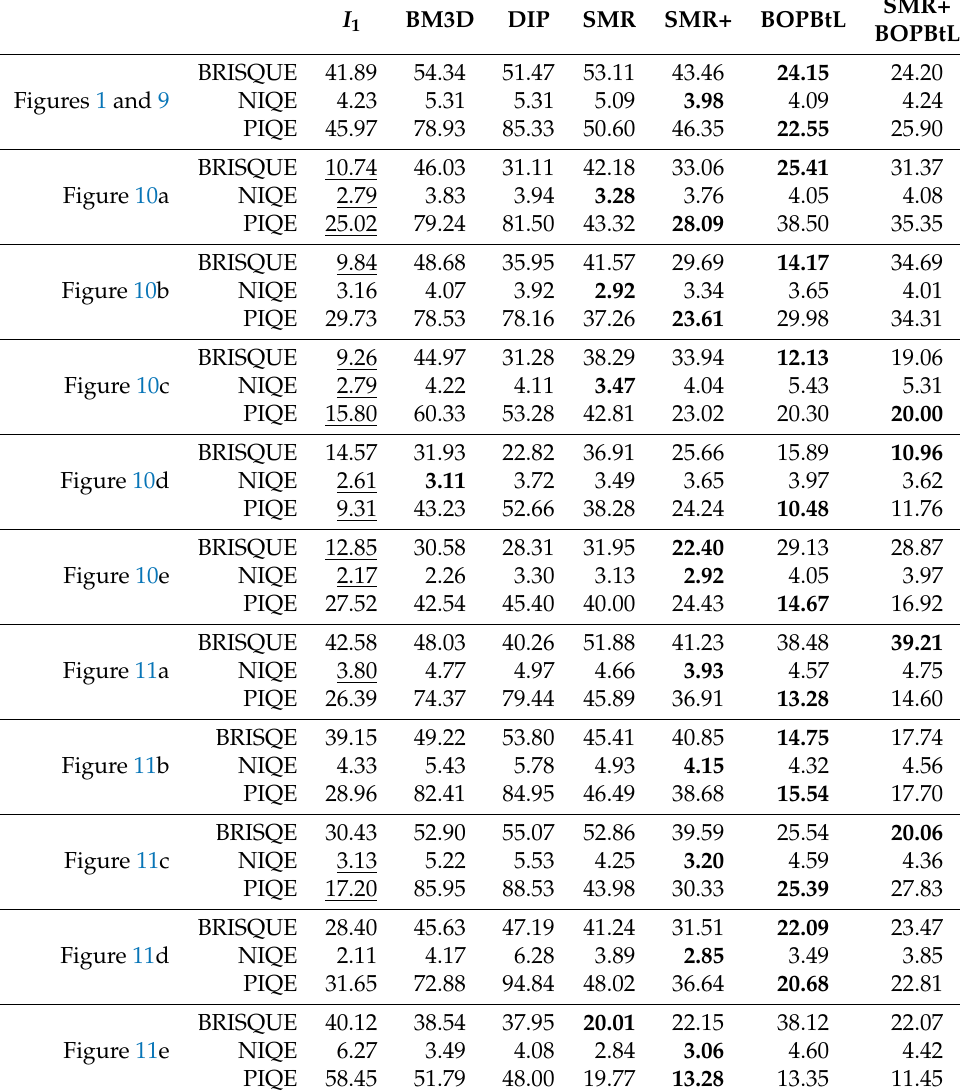
Table 2. No-reference assessment metric results (lower values are better). Values in bold indicate the best score among the compared methods. Scores that are better in the original images than in the restored ones are